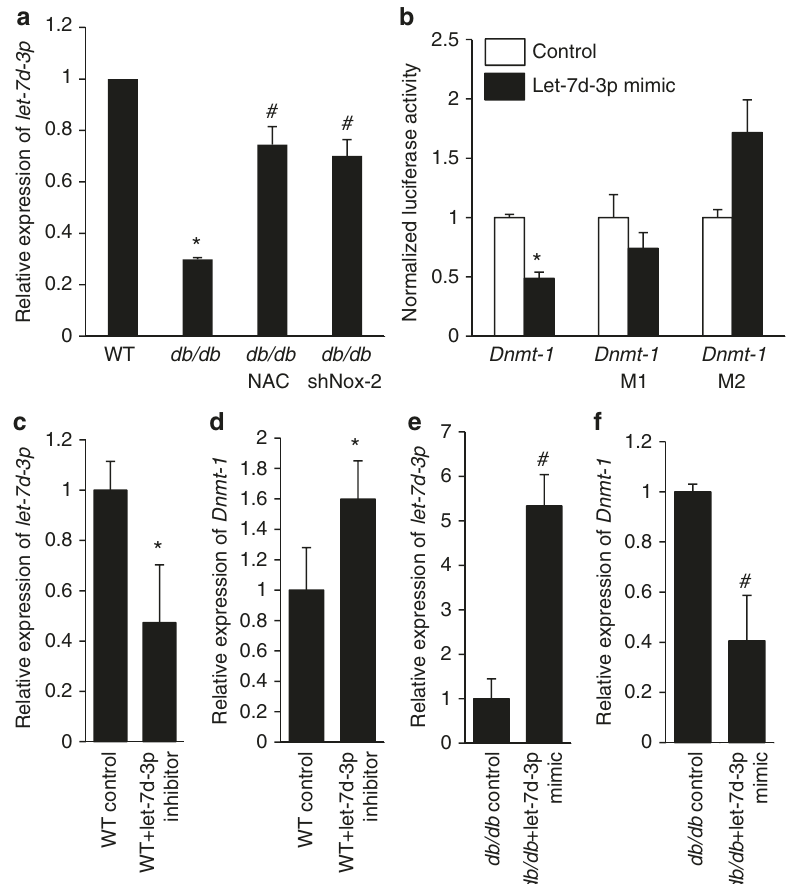
Fig. 5 Dnmt1 is the direct downstream target of microRNA let-7d-3p. a Relative expression of let-7d-3p in db/db HSCs ( n = 6, * p < 0.05 vs. WT; # p < 0.05 vs. db/db ). b Luciferase activity assay ( n = 4, * p < 0.05 vs. control). Dnmt1 M1 represents mutant #1 and Dnmt1 M2 represents mutant #2. c Relative expression of let-7d-3p in WT HSCs following transfection with a let-7d-3p inhibitor ( n = 6, * p < 0.05 vs. WT control). d Relative expression of Dnmt1